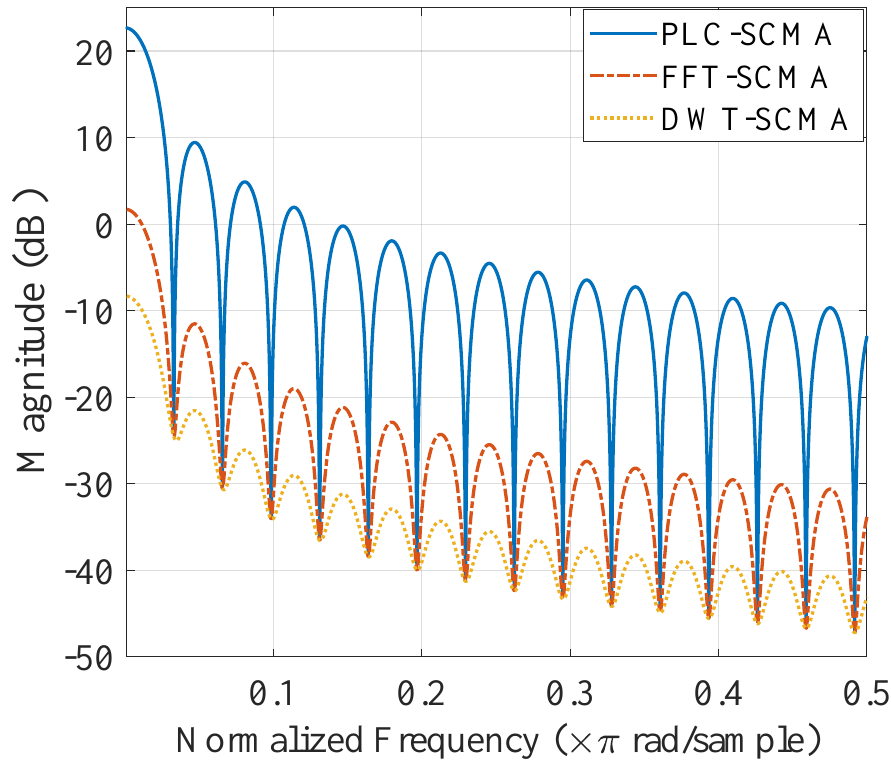
Figure 8. Out-of-band radiation comparison among PLC-SCMA, FFT-SCMA, and